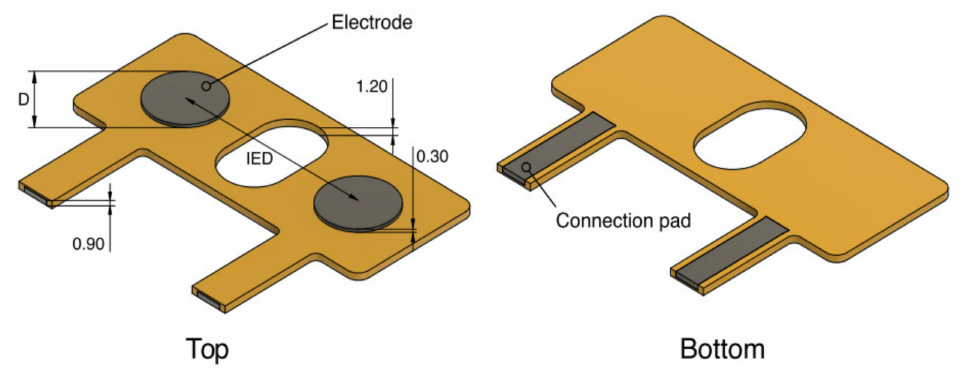
Figure 6. CAD drawing of the electrodes; the gray parts are made of conductive PI-ETPU while the non-conductive segment is made of non-conductive Ninjaflex